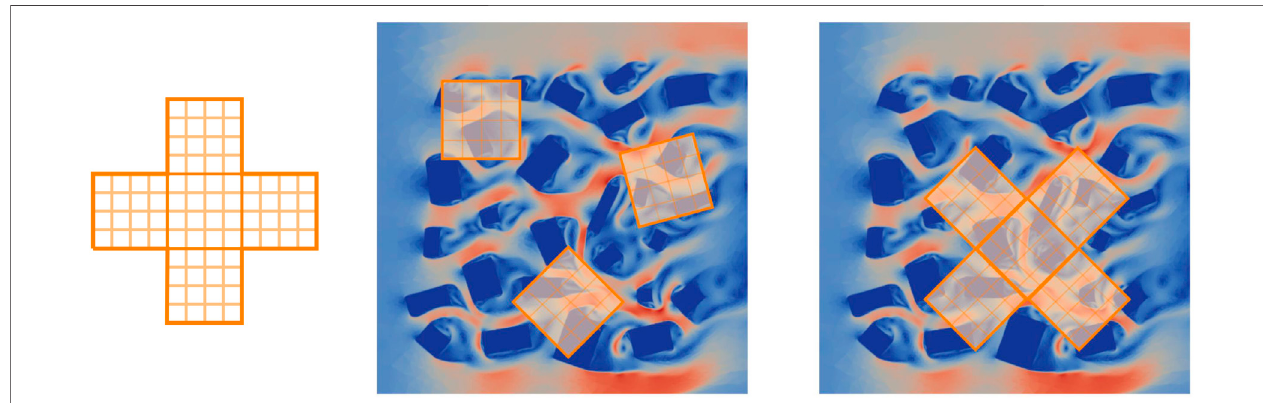
FIGURE1| Left:thestar-shapedgrid;centre:randomplacementofcentralsubdomainofthegrid(forobtainingdatatotrainCAEs);right:randomplacementofthe star-shaped grid (for obtaining data to train the predictive adversarial network).